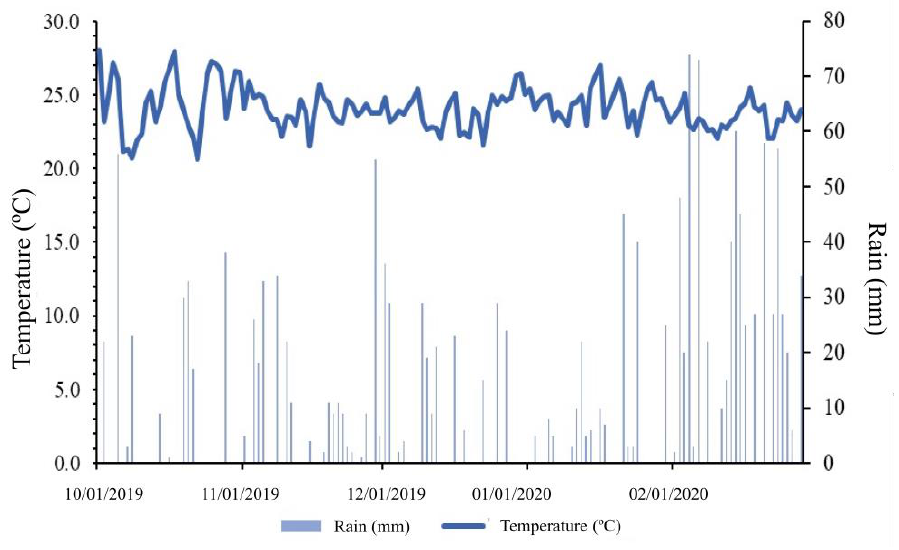
Figure 1. Weather conditions over the 2019/2020 crop season. A total of 103 F 2 populations of soybean were evaluated in a randomized block design with two repetitions, in which the plants in the central three-meter-long row of each plot were evaluated. The spacing between rows was 0.45 m, and planting density was 15 plants − m . Sowing was performed in October 2019, adopting the soil preparation system (plowing and harrowing). Seeds were treated with fungicide (Pyraclotrobin + Methyl Thiophanate) and insecticide (Fipronil) at a dose of 200 mL of the commercial product for every 100 kg of seeds to prevent pests and soil fungus. The seeds were also inoculated with bacteria of the Bradyrhizobium genus at a dose of 200 mL of concentrated liquid inoculant for each 100 kg of seeds. Crop treatments were performed according to the needs of the